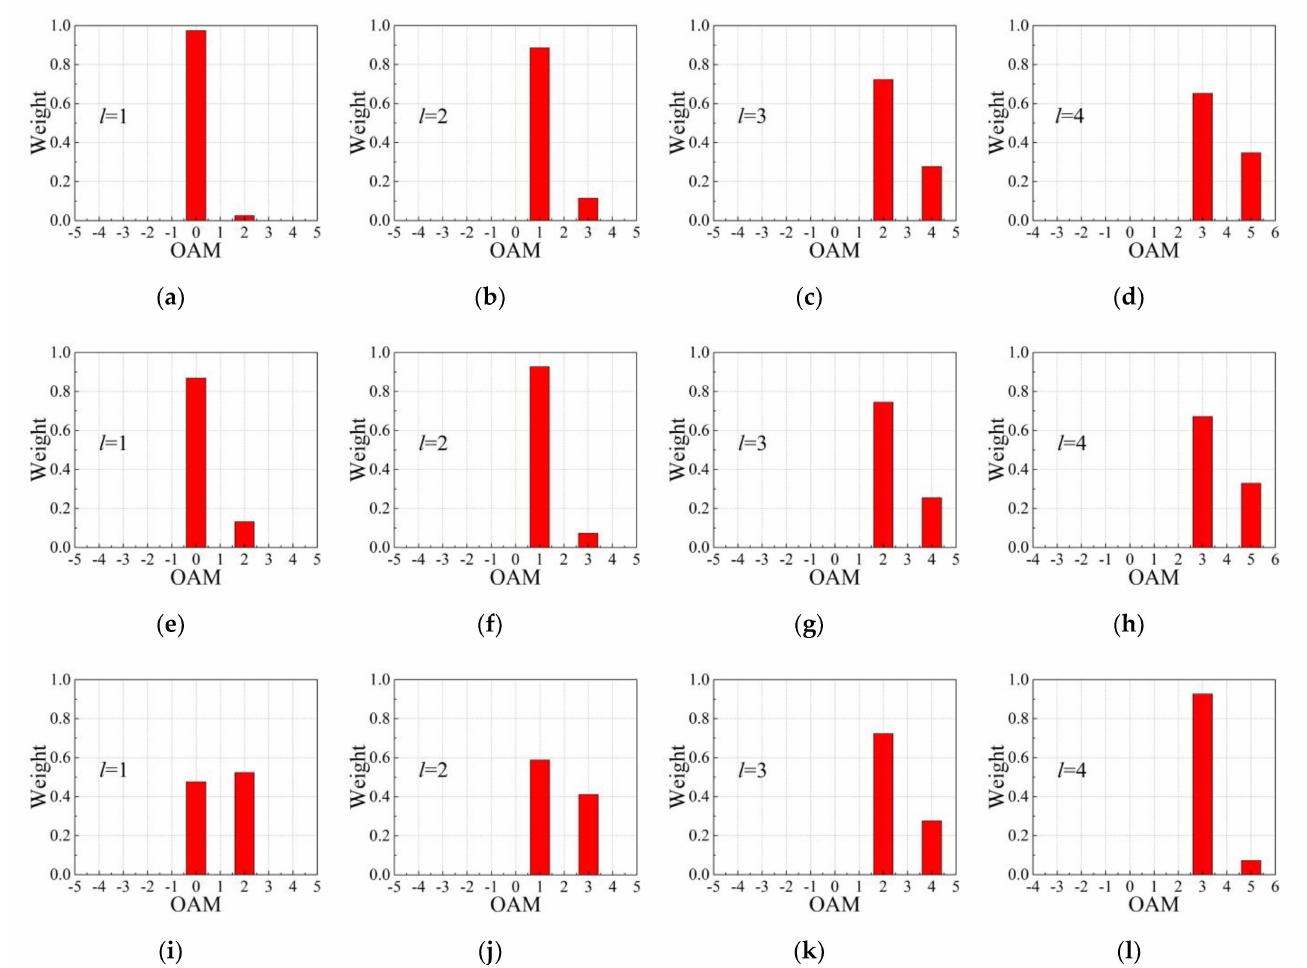
Figure 17. The same as in Figure 16, but the radial polarization is